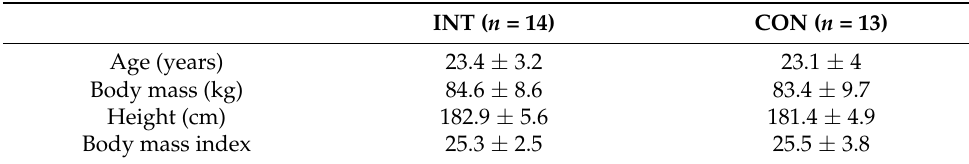
Figure 1. Flow of participants through the study. Table 1. Baseline anthropometric characteristics.